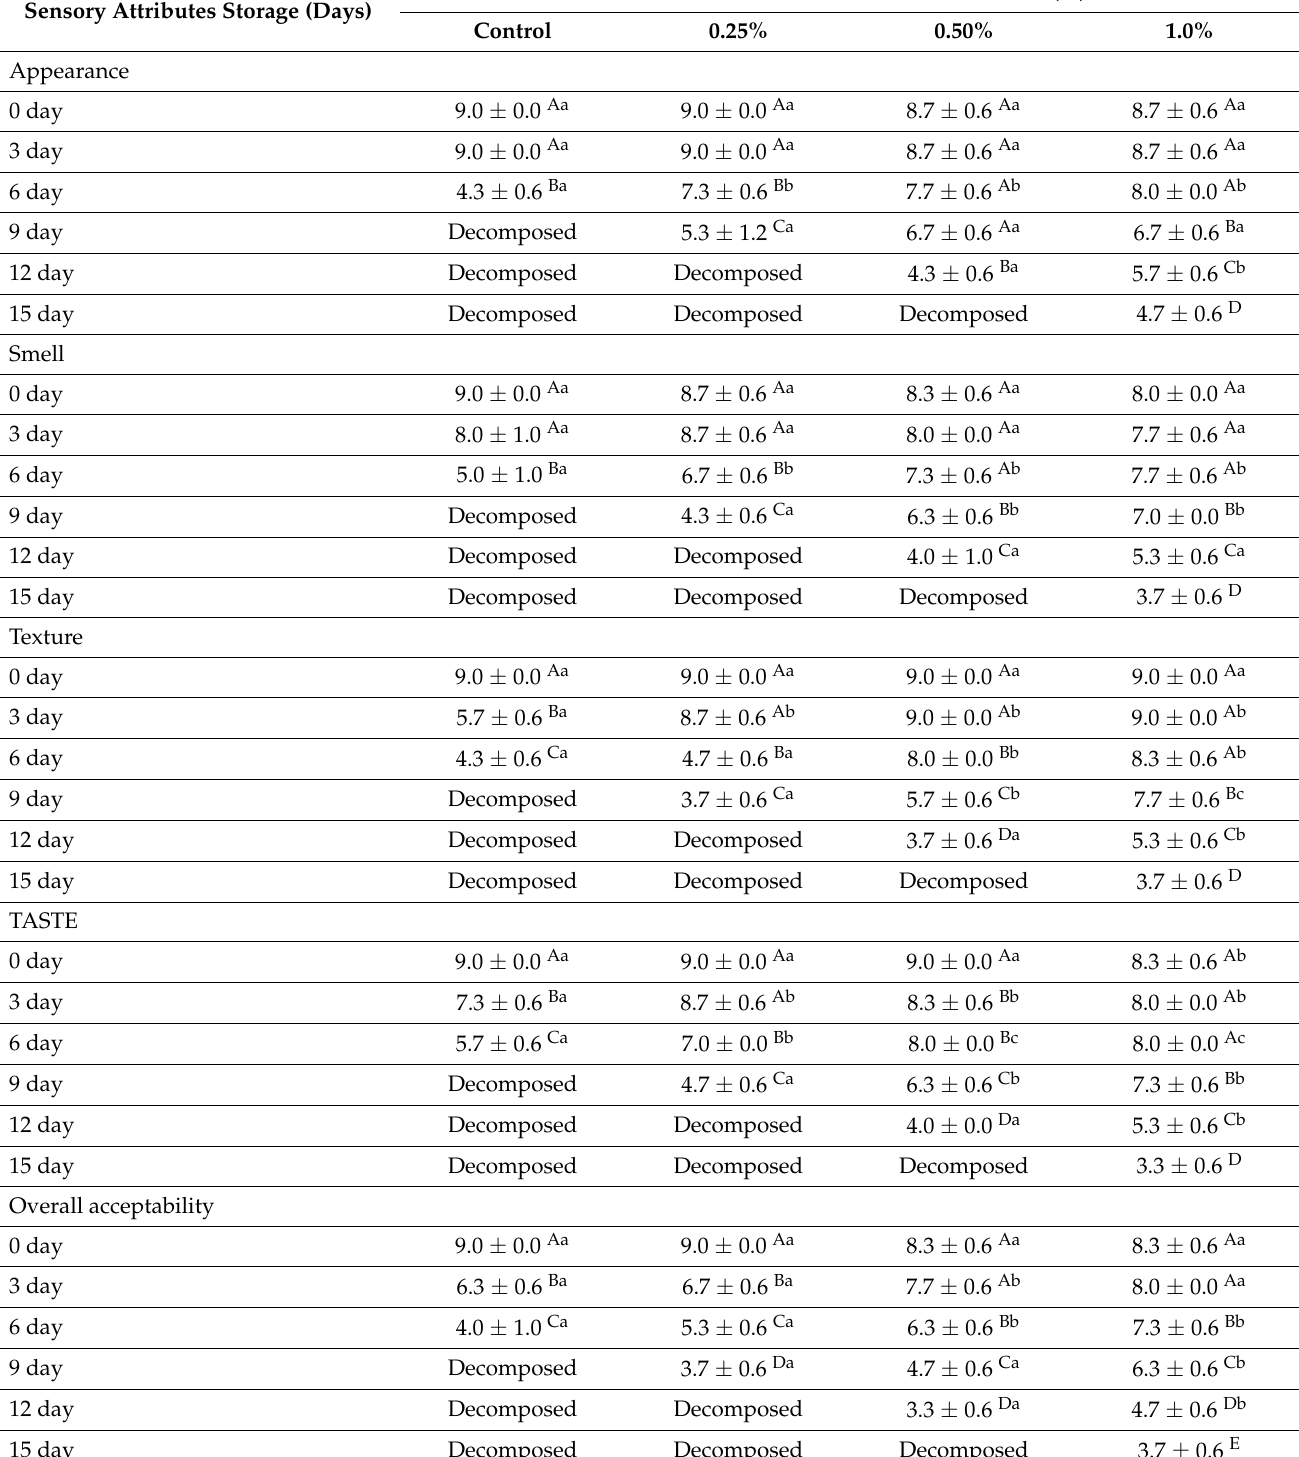
Table 1. Changes in sensory attributes of minced beef samples treated with ethanolic Cassia